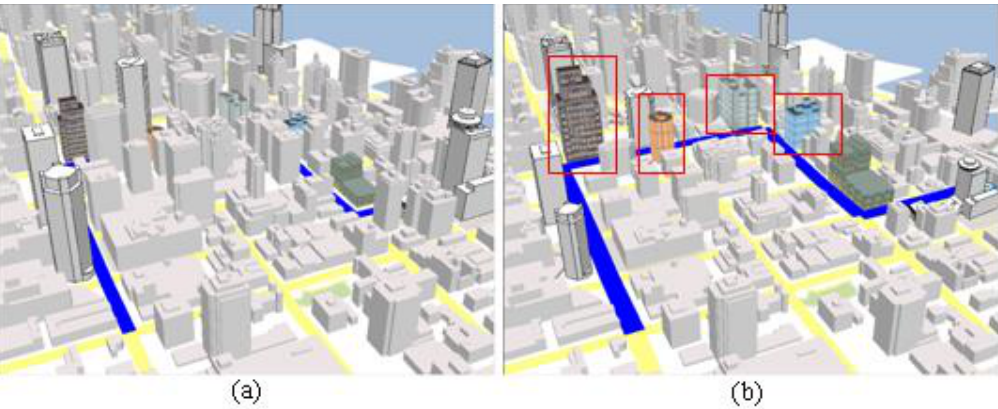
Figure 10. A route and some associated landmarks in Vancouver. ( a ) The route (blue) and its associated four landmarks (red rectangles) are occluded by other buildings; and ( b ) the same route and the landmarks after disocclusion by our optimization method.